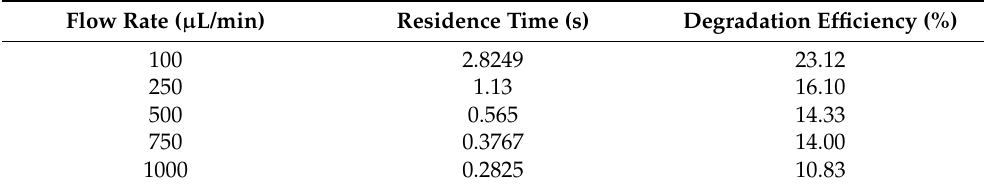
Table 5. Degradation of MB using the microfluidic device under light